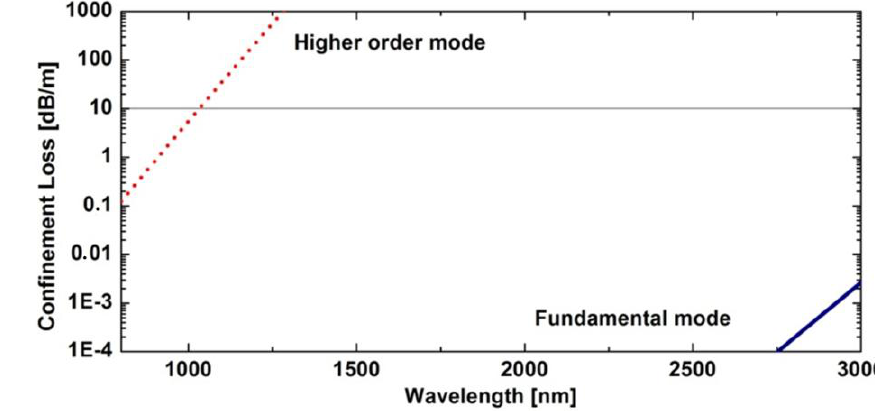
Figure 3. Confinement losses versus wavelength, computed using finite element method for the fundamental and higher order mode of the developed photonic crystal fibers